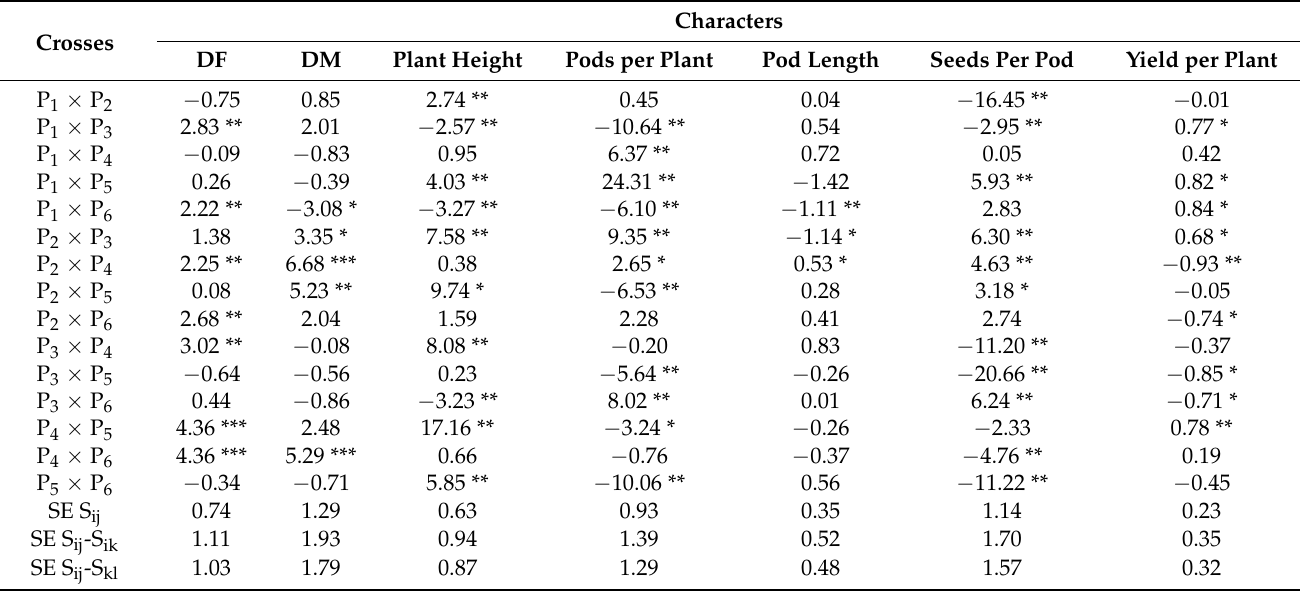
Table 4. Specific combining ability effects of the different 15 crosses for yield and its related traits in